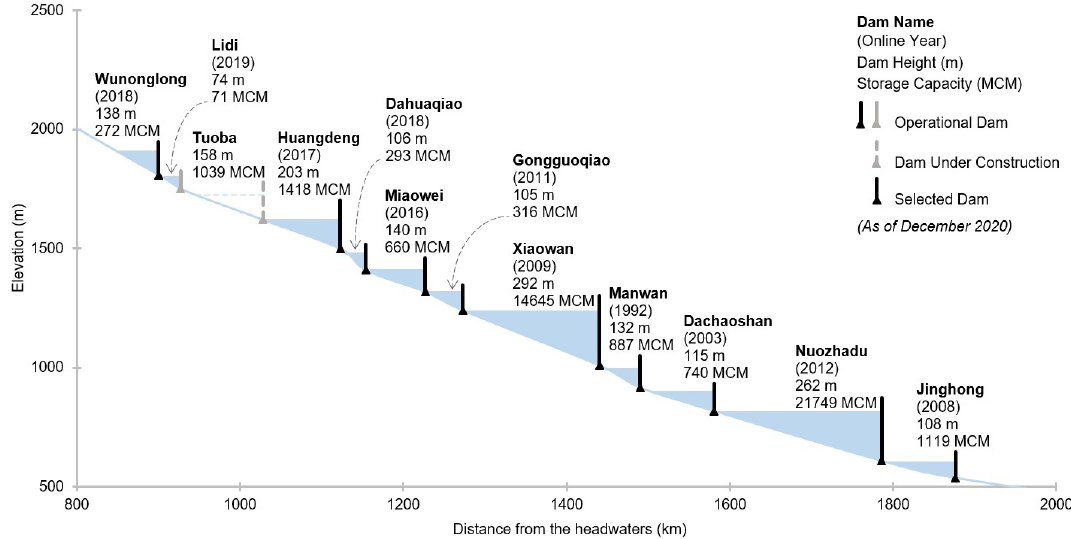
Figure 2. Cascade reservoir system on the Lancang River. Further details about the design specifications are provided in Table S1.